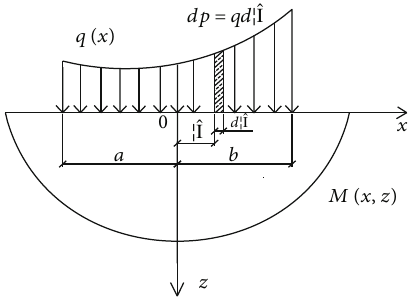
Figure 2: Half in fi nite plane load distribution.